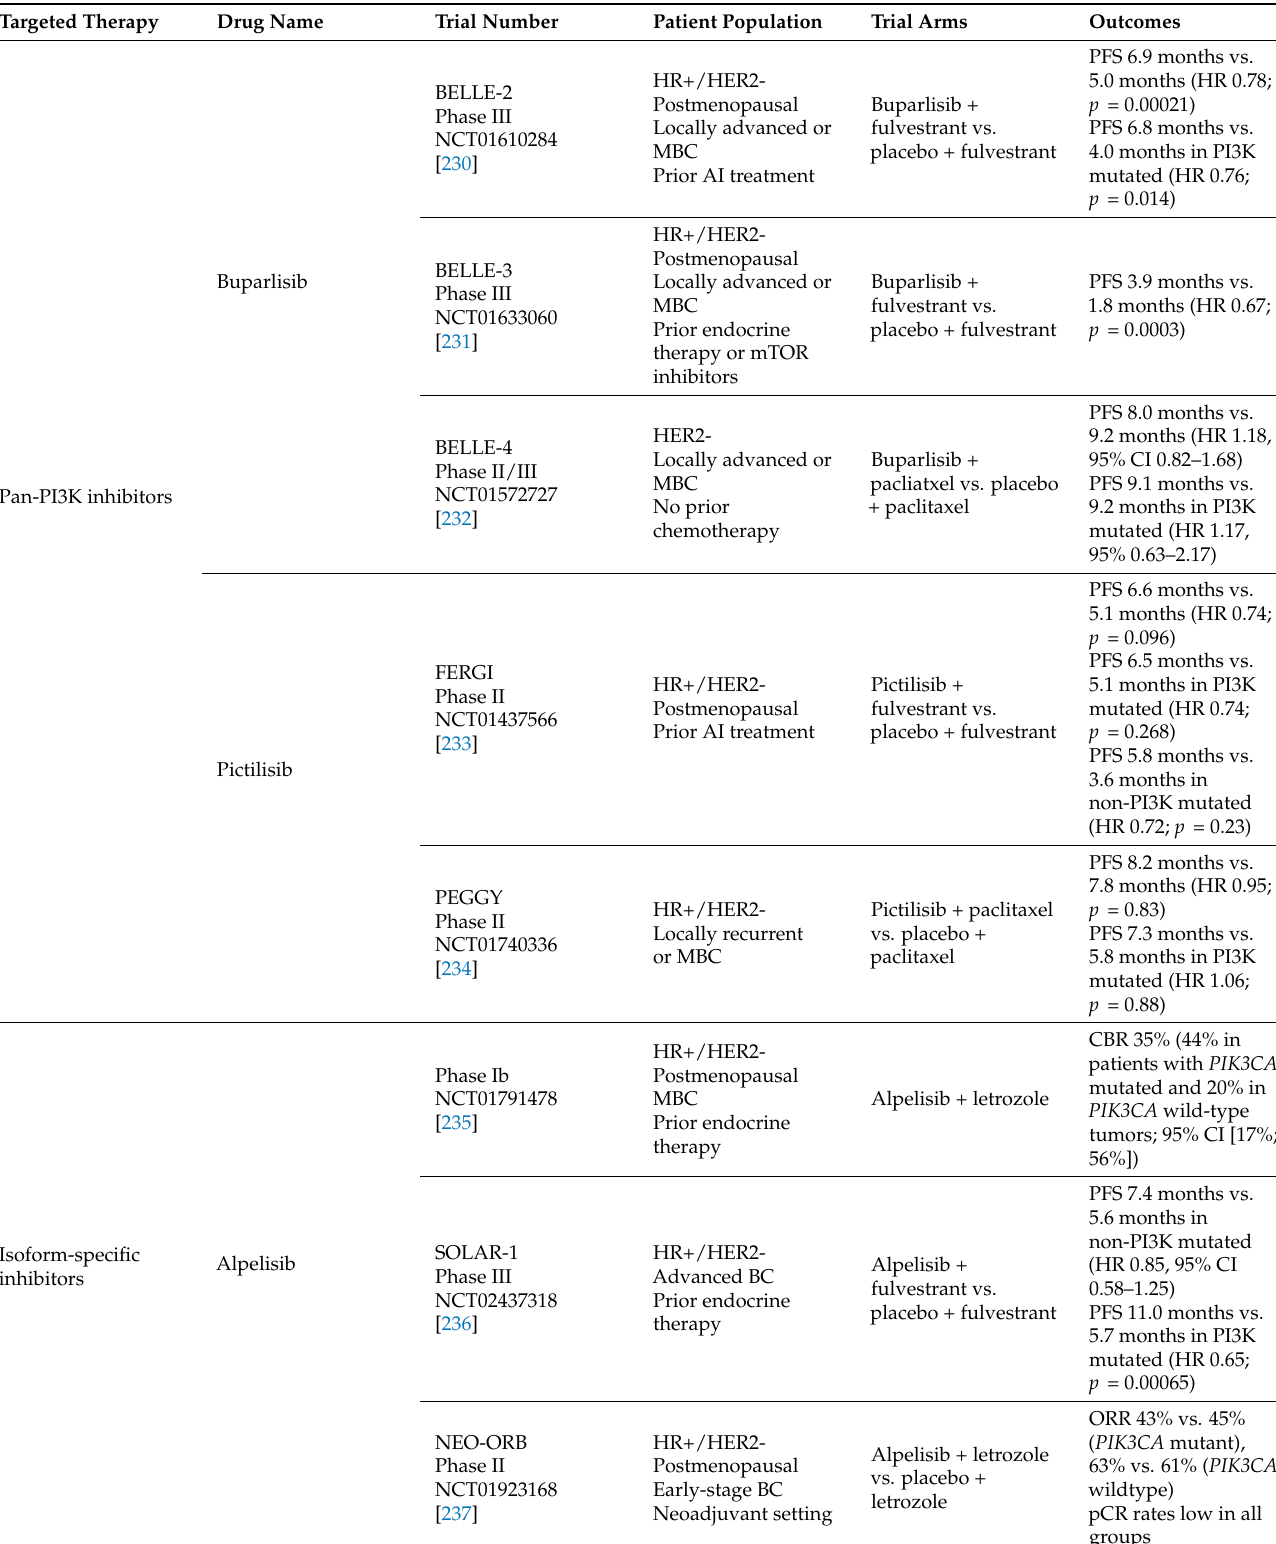
Table 1. Most recent completed clinical trial on emerging therapies for HR-positive breast